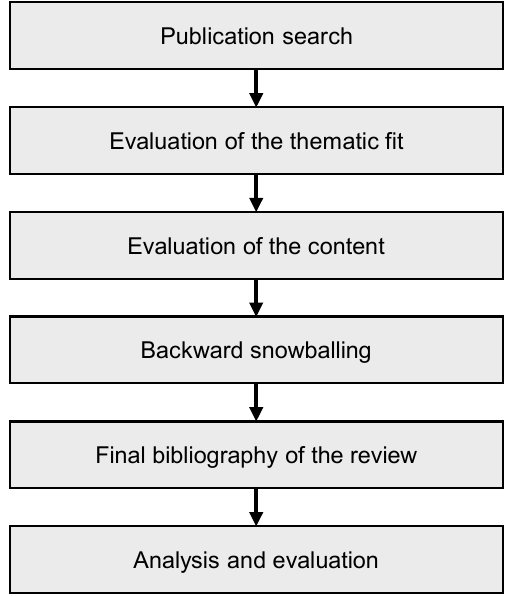
Figure 5. Procedure of the secondary data collection based on the methodology developed by Kitchenham and Brereton (2013) [33].